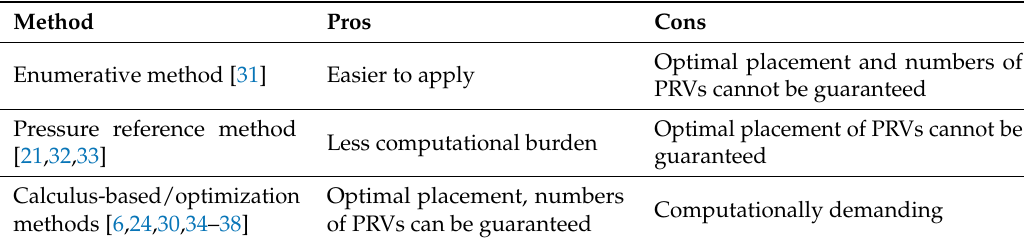
Table 3. Brief summary of classes of methods for the placement pressure reduction valves in water distribution